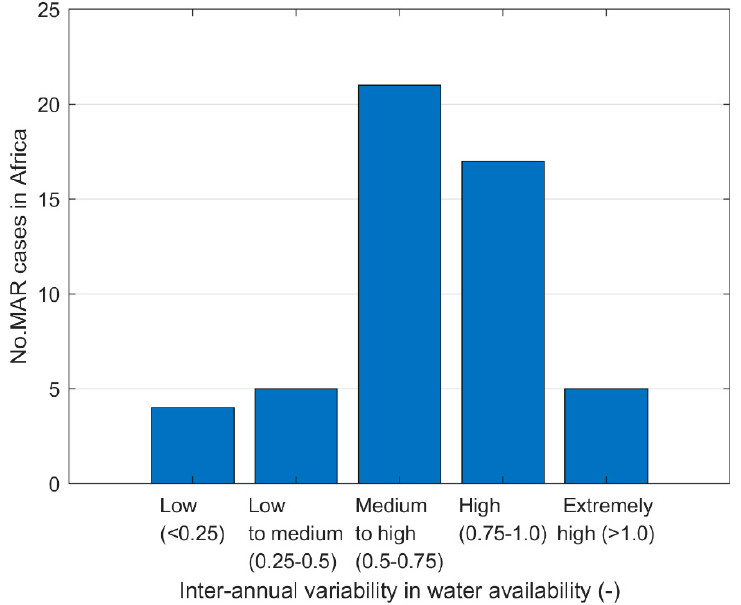
Figure 8. Number of MAR cases in Africa per inter-annual variability in surface water availability class (n = 52).